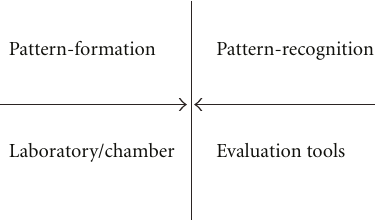
Figure 3: The detail of biocrystallization method